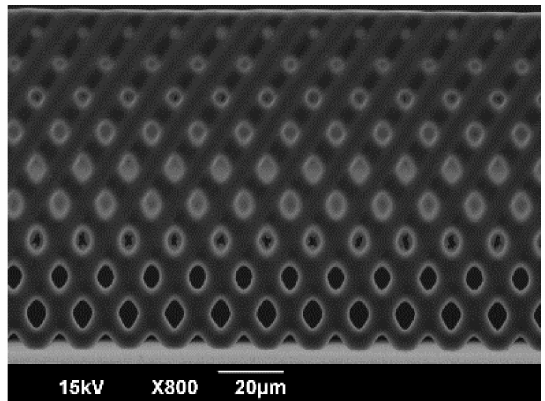
Figure 5. SEM image of the enlarged view of a membrane which is porous to middle point. The pore in the case of “porous to middle point” is closed by a thin